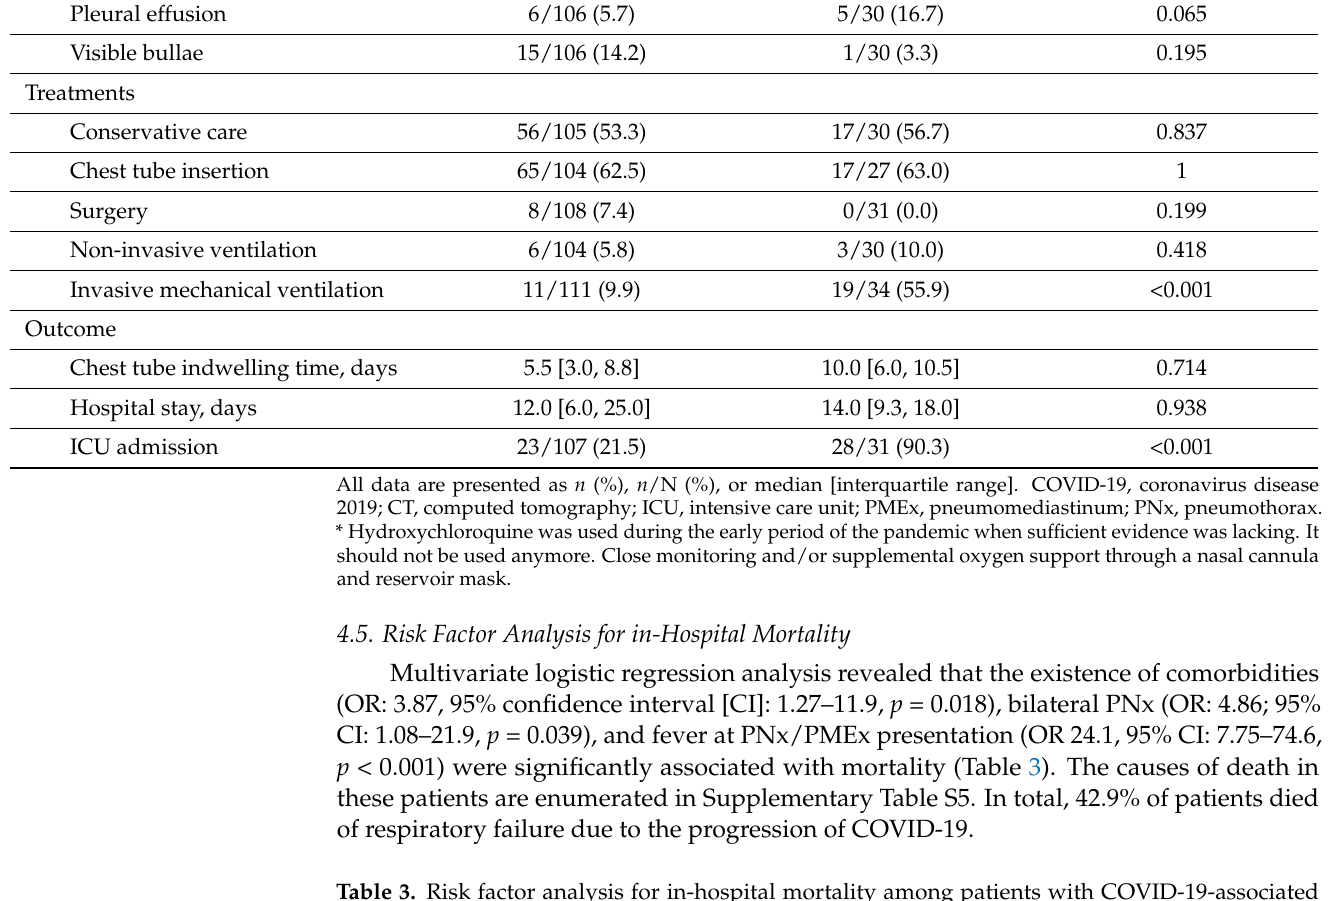
Table 3. Risk factor analysis for in-hospital mortality among patients with